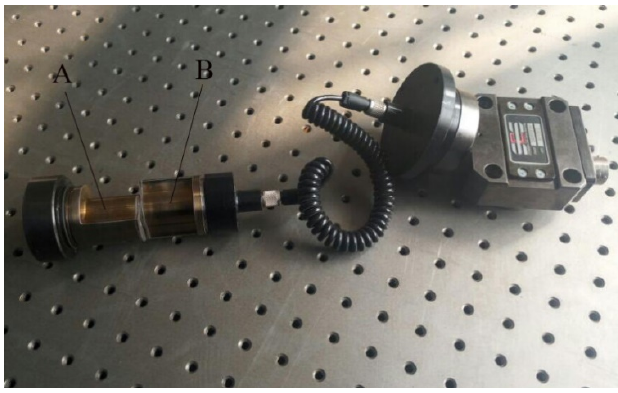
Figure 1. Physical picture of balance head